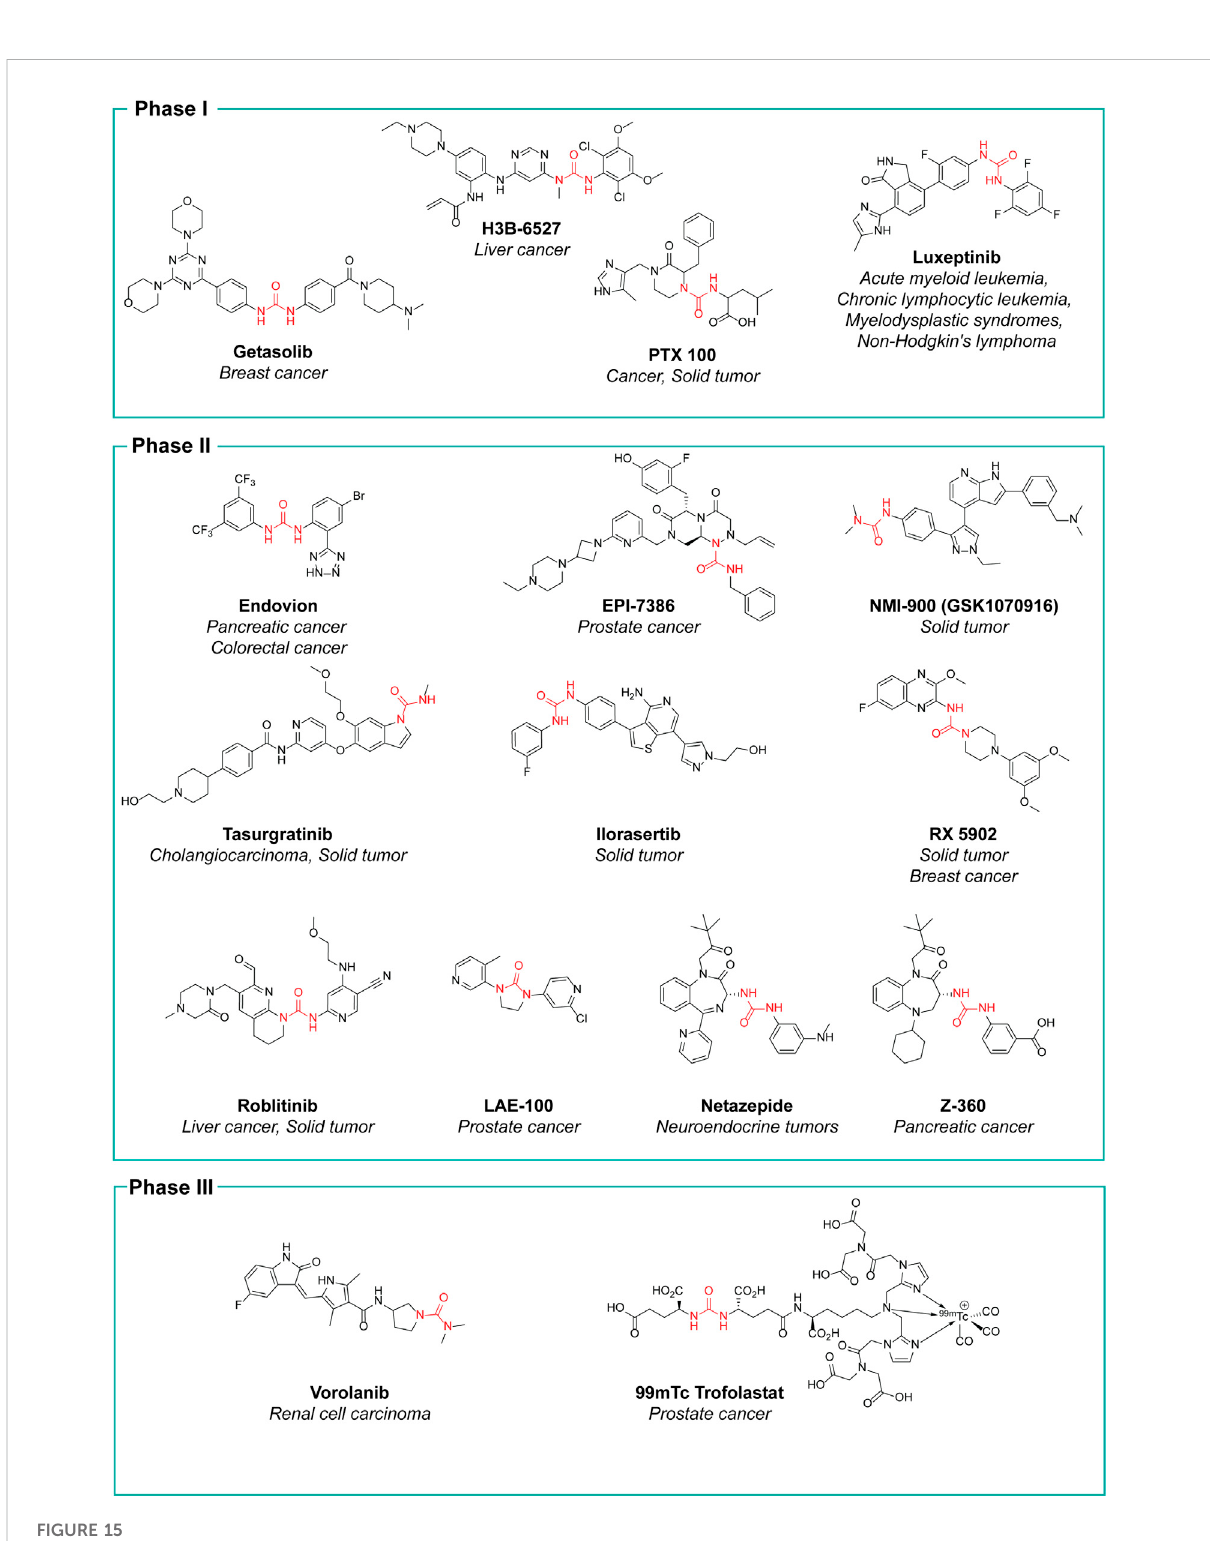
FIGURE 15 Urea-containing compounds currently under clinical evaluation as anticancer agents. For each drug candidate, the highest phase of clinical trials that has been attained is indicated, along with the speci fi c therapeutic indication.